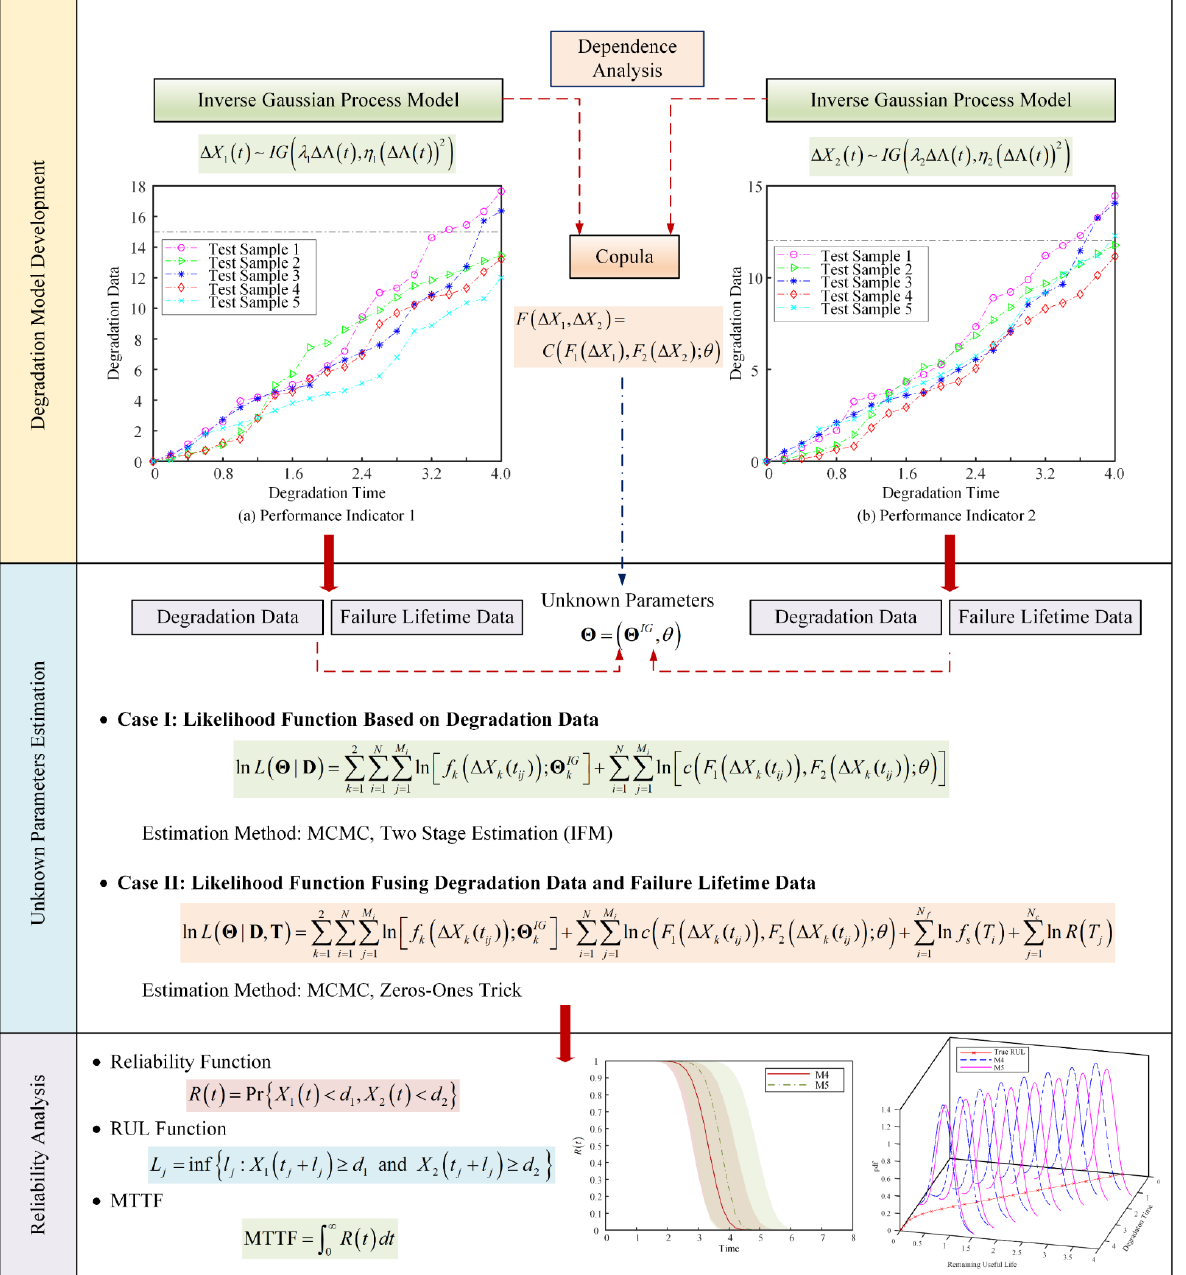
Figure 1. Flow chart for bivariate ‐ dependent reliability analysis.